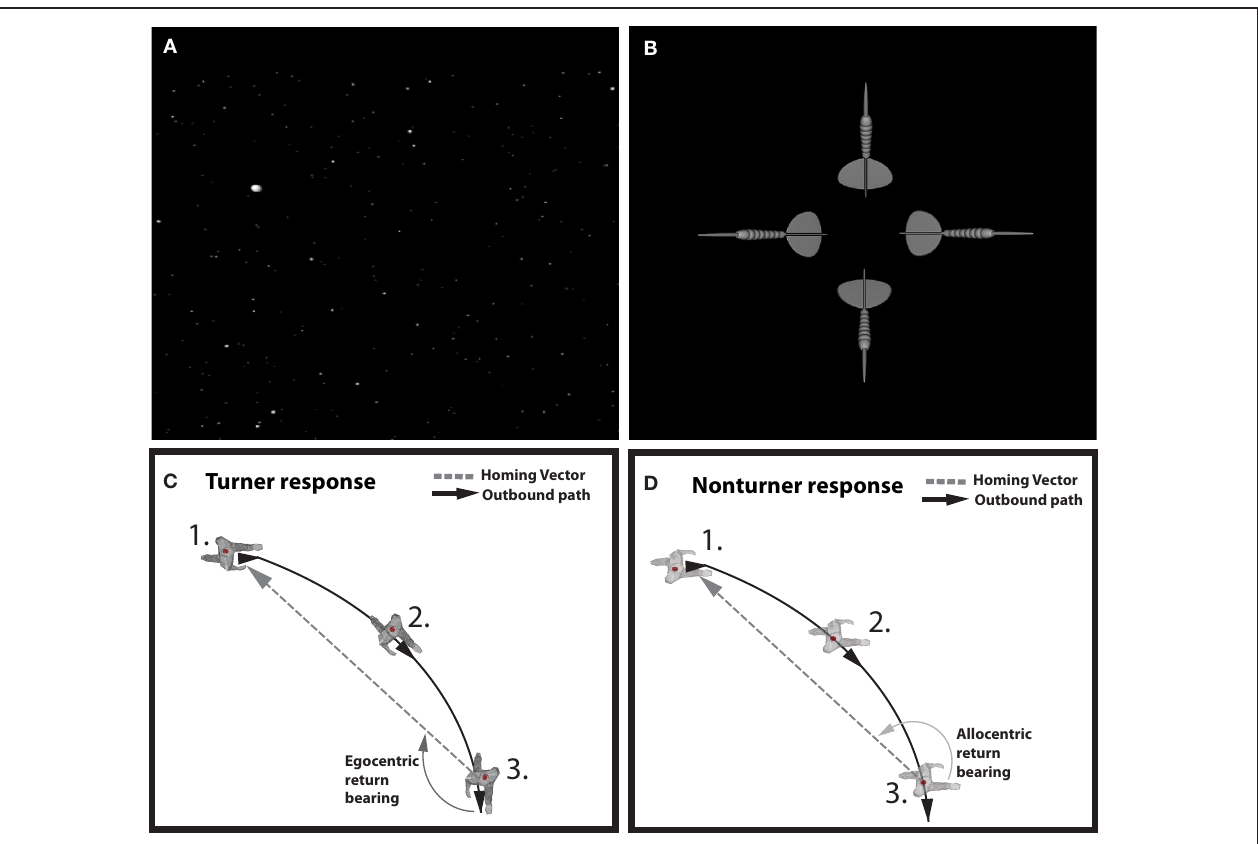
FIGURE 1 | Experimental paradigm. (A) Snapshot of the star-field passage in the experiment. During the passage the white dots (stars)-induced visual flow indicating a turn into one direction. (B) Forced choice arrow selection in the experiment. After a 90 ◦ rightward turn. The arrow pointing to the right indicates the homing vector in line with an egocentric reference frame; the arrow pointing to the left is congruent with an underlying allocentric reference frame. Choosing one of the other two arrows (up and down in this case) was counted as incorrect response. (C,D) Turner and Non-turner responses respectively in a schematic drawing of a 90 ◦ rightward turn from a bird’s eye view. The curved black line